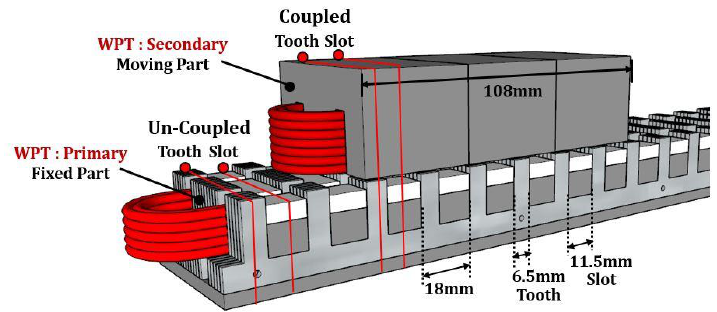
Figure 8. Division of inductance calculation sections.